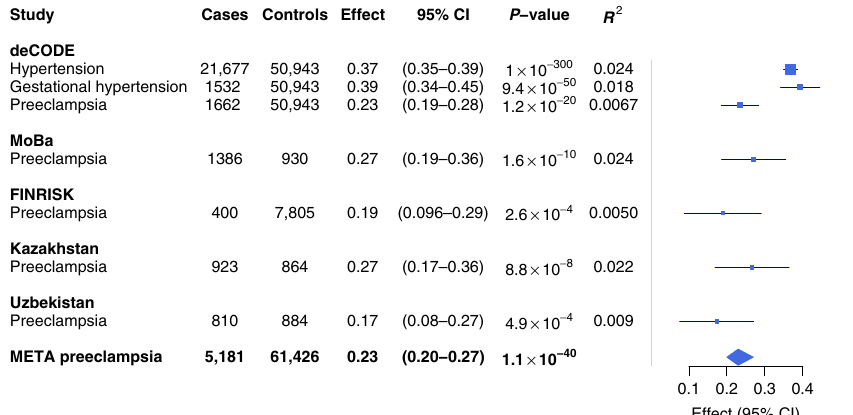
Fig. 3 Polygenic risk score analysis using PRS for hypertension. PRS effect estimates were based on GWAS analysis of the UKBB hypertension data set. The top panel shows association between the HT-PRS and hypertension (females only), gestational hypertension and preeclampsia in genotyped subjects from the deCODE cohort. The control group comprises females that are not on any of the case lists (hypertension-free controls). For other studies, the association analysis used the preeclampsia cases and controls that were included in the respective maternal GWAS analyses. Effect reported as log-odds corresponds to the increase in risk of the respective trait for one standard deviation of the hypertension risk score. 95% CI: 95% con fi dence interval. P -values are obtained from logistic regression of case status on individuals ’ polygenic risk score, adjusted for covariates (see “ Methods ” section). All P -values are two-sided. R 2 denotes the explained